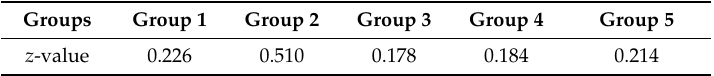
Table 16. Design values ( z ) for cutting facilities groups (obtained from Equation (17)).